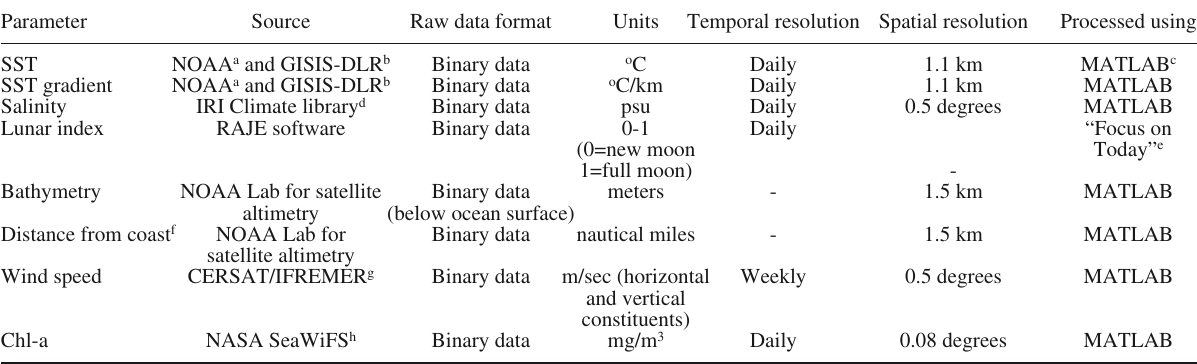
Table 2. – Summary of environmental parameters specifications included in the